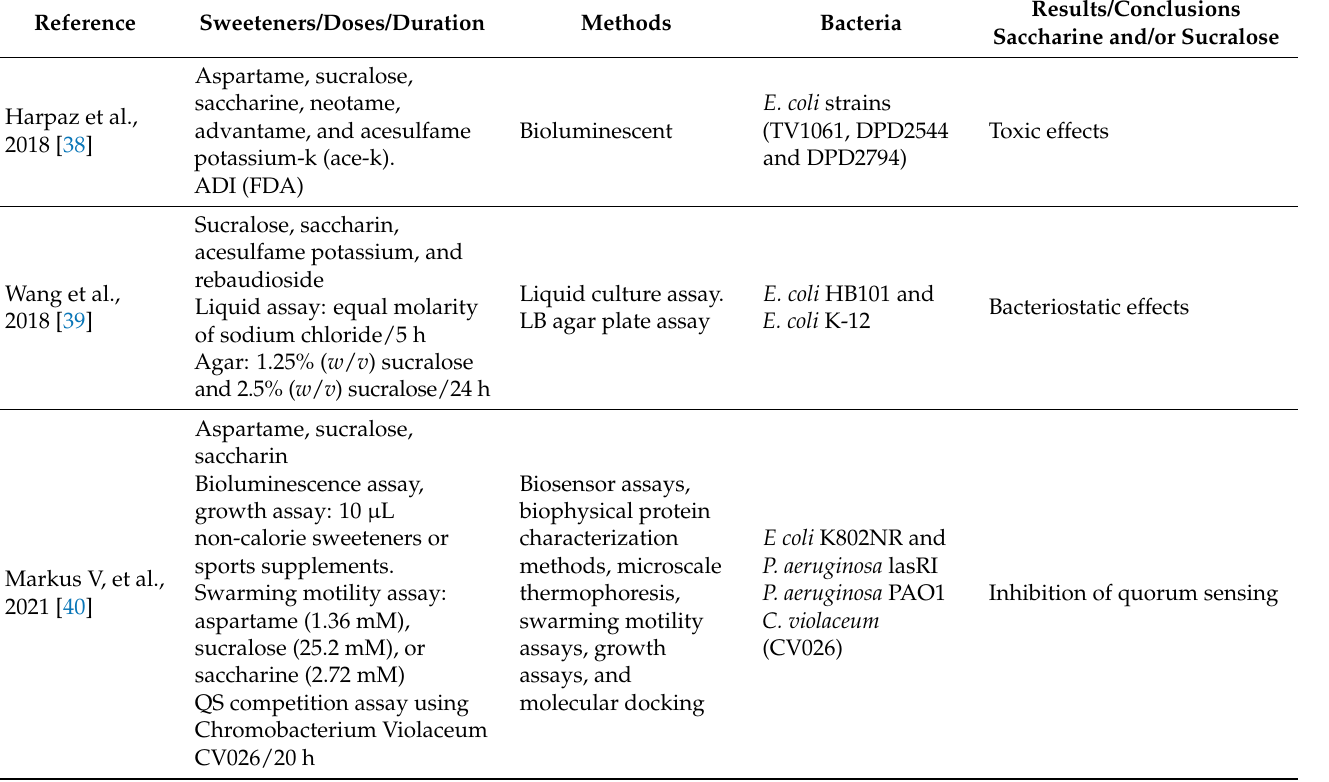
Table 3. Summary of the analyzed in vitro